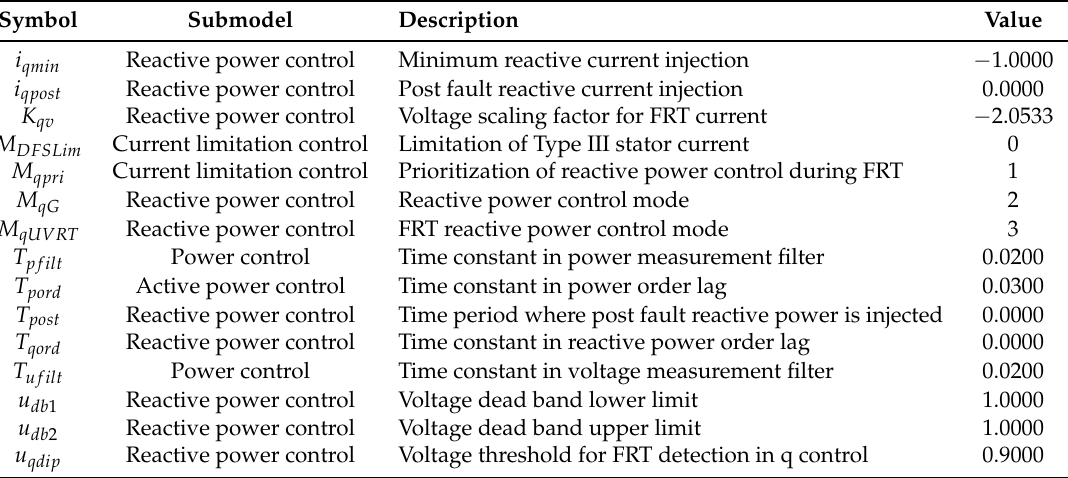
Table A2. Parameters for the generic IEC Type IVA